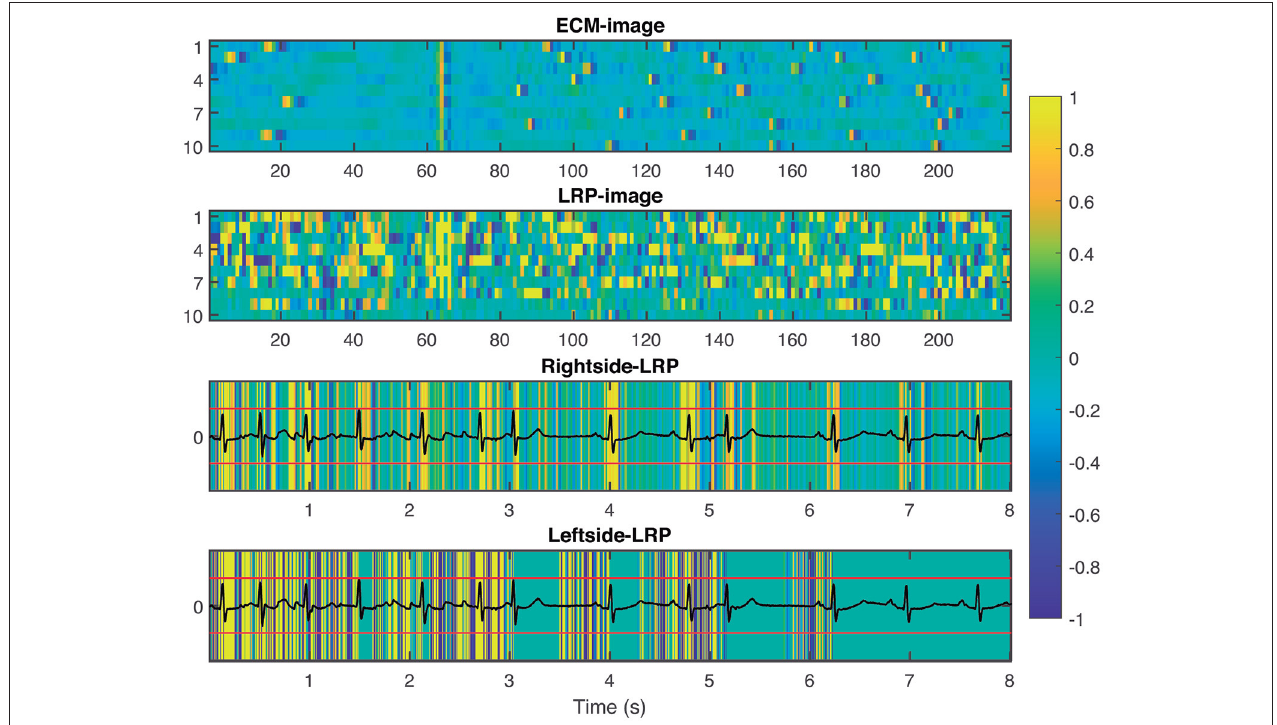
FIGURE 6 | From top to bottom : ECM-image labeled as non-AF and misclassified as AF, heatmap image resulting from the LRP process, rightside-LRP, and leftside-LRP. Premature beats are interpreted as irregular rhythm by the network resulting in a FP prediction.